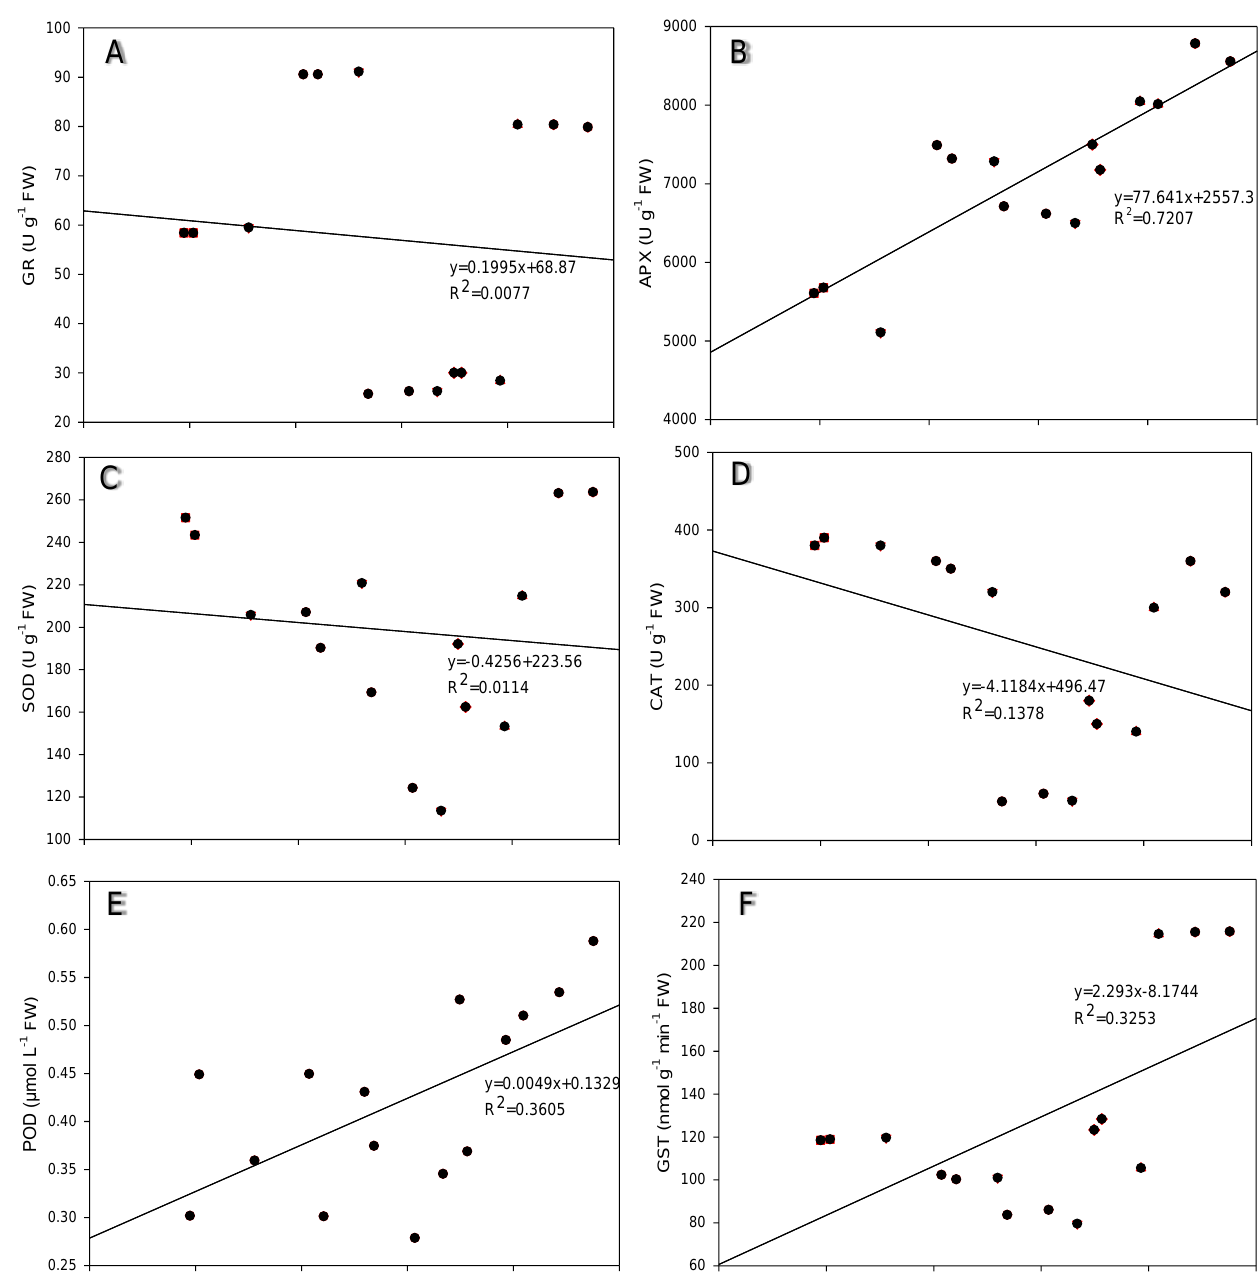
Figure 7. Correlations between arginine content and the activities of glutathione reductase (GR) ( A ), ascorbate peroxidase (APX) ( B ), superoxide dismutase (SOD) ( C ), catalase (CAT) ( D ), peroxidase (POD) ( E ), and glutathione-S-transferase (GST) ( F ).